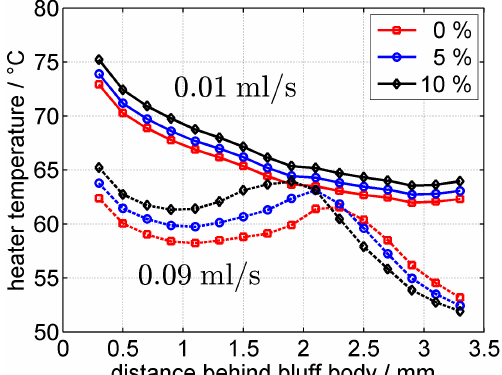
Figure 14. Measured temperature increase (averaged over the last 2s of every heat pulse) of the individual heaters of the array for different volume fractions of methanol in water for constant flow rates of 0.01 and 0.09mLs − 1